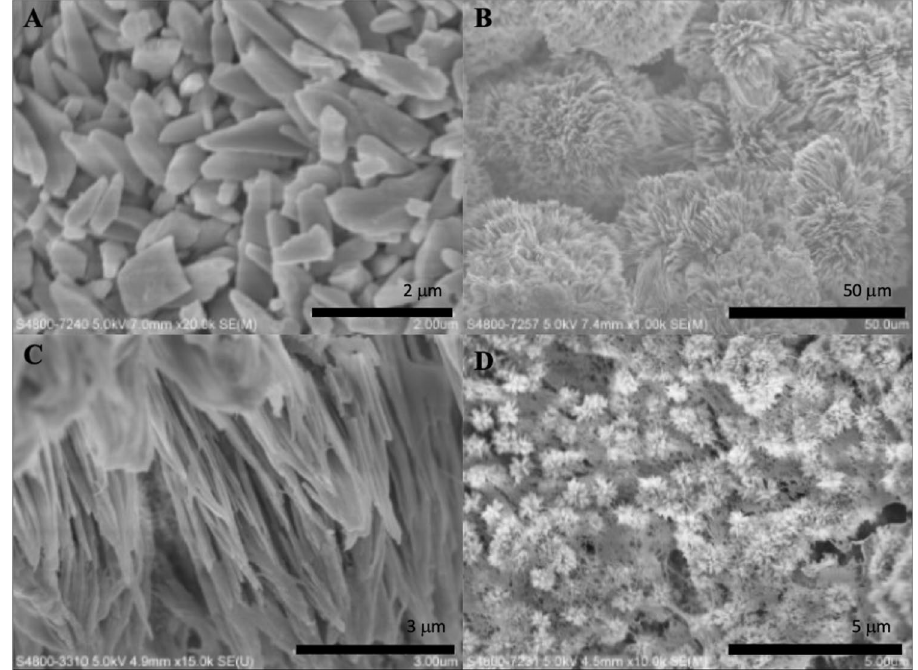
Figure 1. SEM micrographs of formed crystals treated with different strength of electric current. ( A ) 5 mA; ( B ) 8 mA; ( C ) 10 mA; ( D ) 12